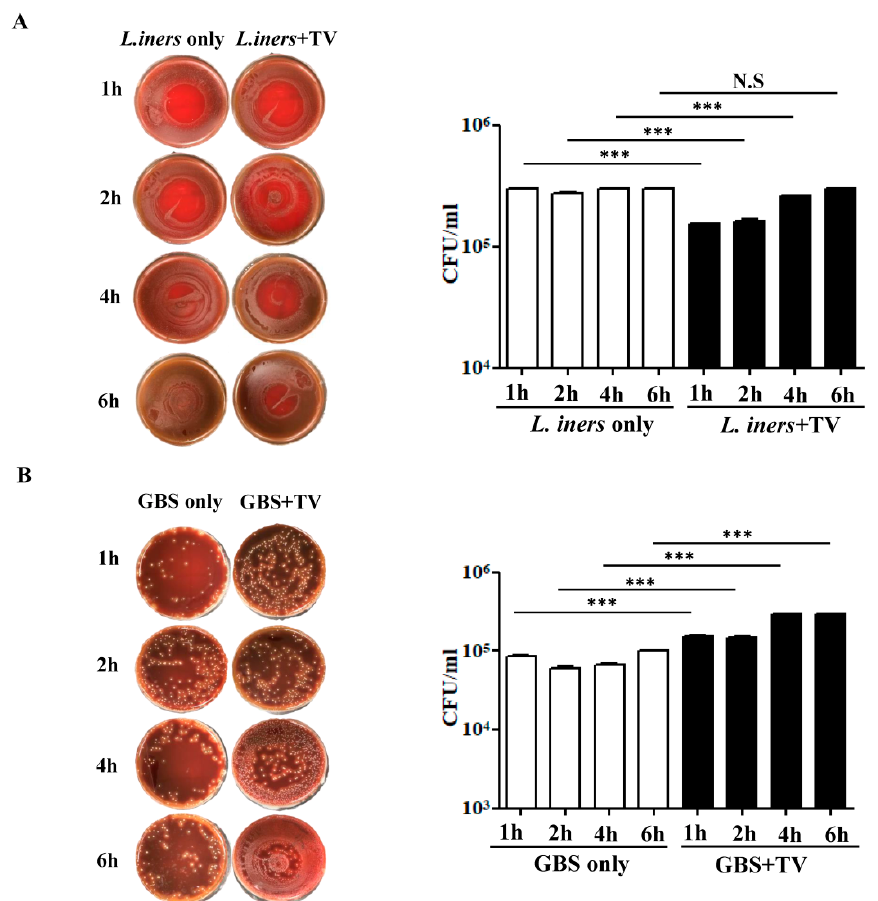
Figure 4. The effect of TV–bacteria interactions on the growth of specific bacteria enriched from microbiome analysis. TV (5 × 10 5 cells/mL) was co-cultured with L. iners ( A ) and GBS ( B ) at a ratio of 1:10 in 1 mL of KSFM medium and the microbial culture was incubated at 37 °C for 1, 2, 4, 6 h. The growth of L. iners and GBS was observed after plating out the culture on blood agar plates for 24 h at 37 °C, followed by CFU counting. Right panels represent the quantitative data of CFUs from three independent experiments. *** p < 0.001, N.S—not significant.